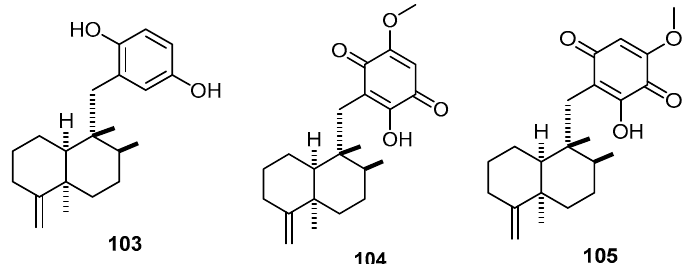
Figure 23. Chemical structures of arenarol ( 103 ), 5-epiilimaquinone ( 104 ) and 21-hydroxy-19- methoxyarenarone ( 105 ).